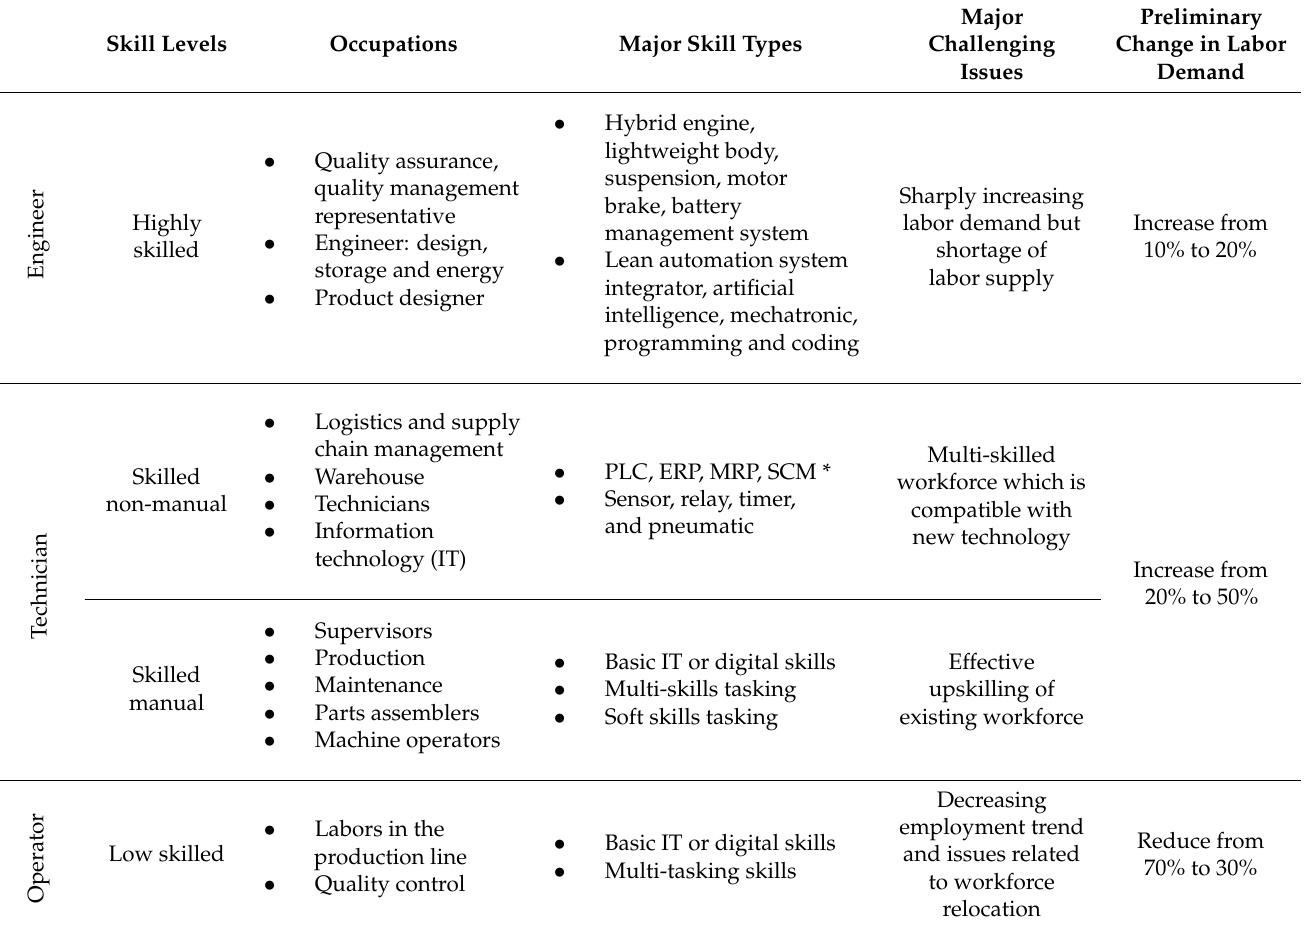
Table 1. Transitional impact on occupations and skills by each skill